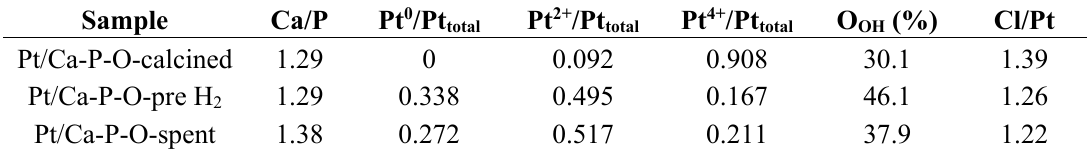
Table 2. Results from XPS analysis of Pt/Ca-P-O